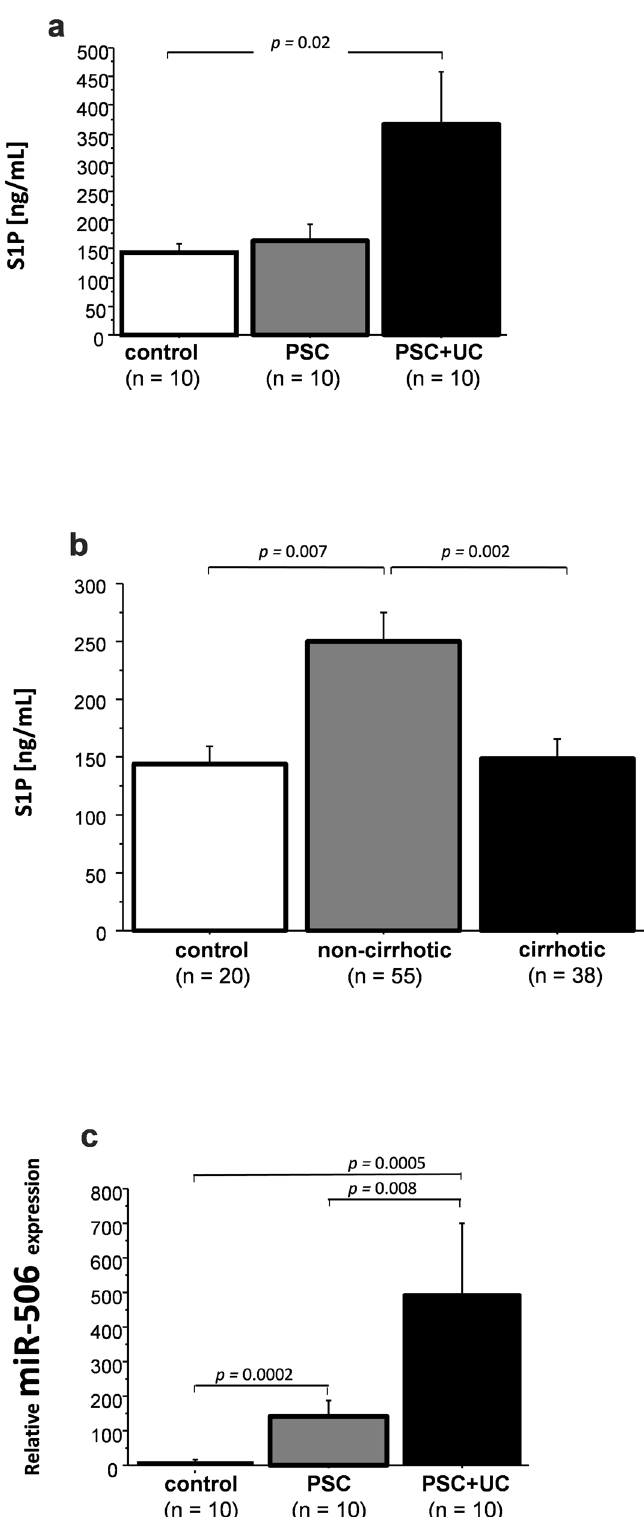
Figure 5. Concentrations of active S1P and relative expression of miR-506 in serum. (a) Circulating concentration of sphingosine-1-phosphate (S1P) in serum of PSC and PSC + UC patients in whom colonic tissue were analyzed. (b) Serum concentration of S1P in controls, non-cirrhotic PSC and in PSC patients with liver cirrhosis. (c) The relative expression of miR-506 in sera of PSC and PSC + UC patients. Data were compared with the Fisher’s (PLSD) test and p-values below 0.05 were considered statistically significant. Bars indicate the mean ± standard error